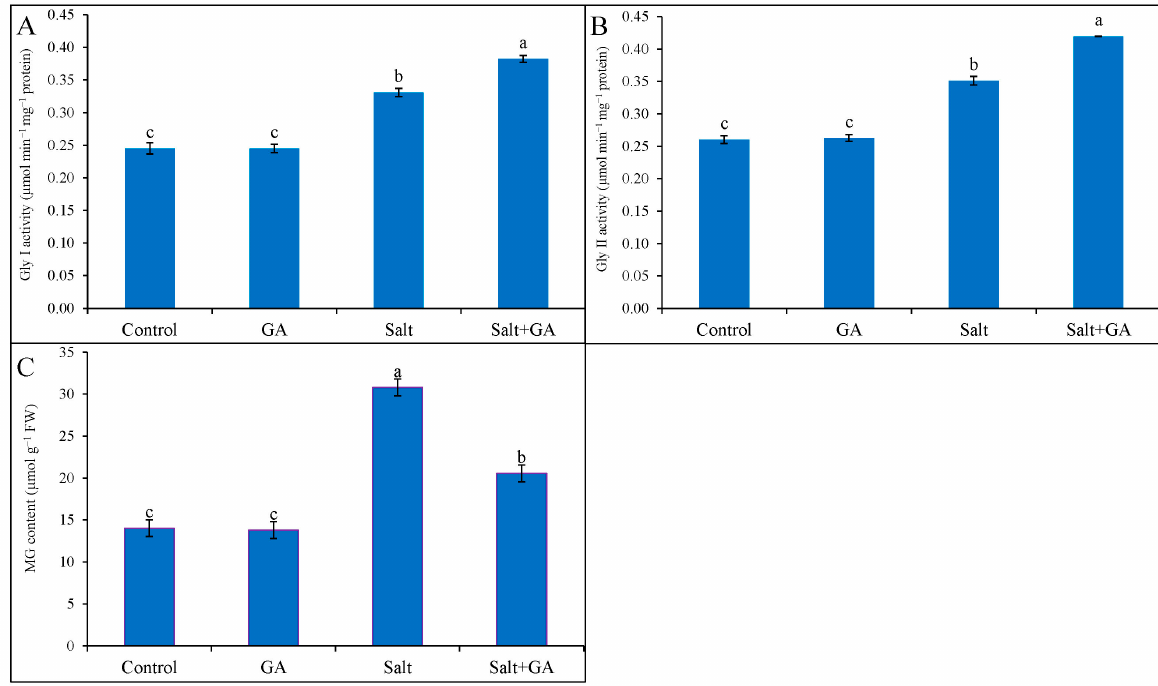
Figure 7. Methylglyoxal accumulation ( C ) and the activities of GA on Gly I ( A ) and Gly II ( B ) en- zymes in salt-treated rice ( O. sativa L. cv. BRRI dhan52) seedlings as influenced by GA supplemen- tation. 1 mM gallic acid and 200 mM NaCl are specified by GA and salt, correspondingly. Values with different letters are significantly different at P ≤ 0.05 applying the Tukey’s HSD